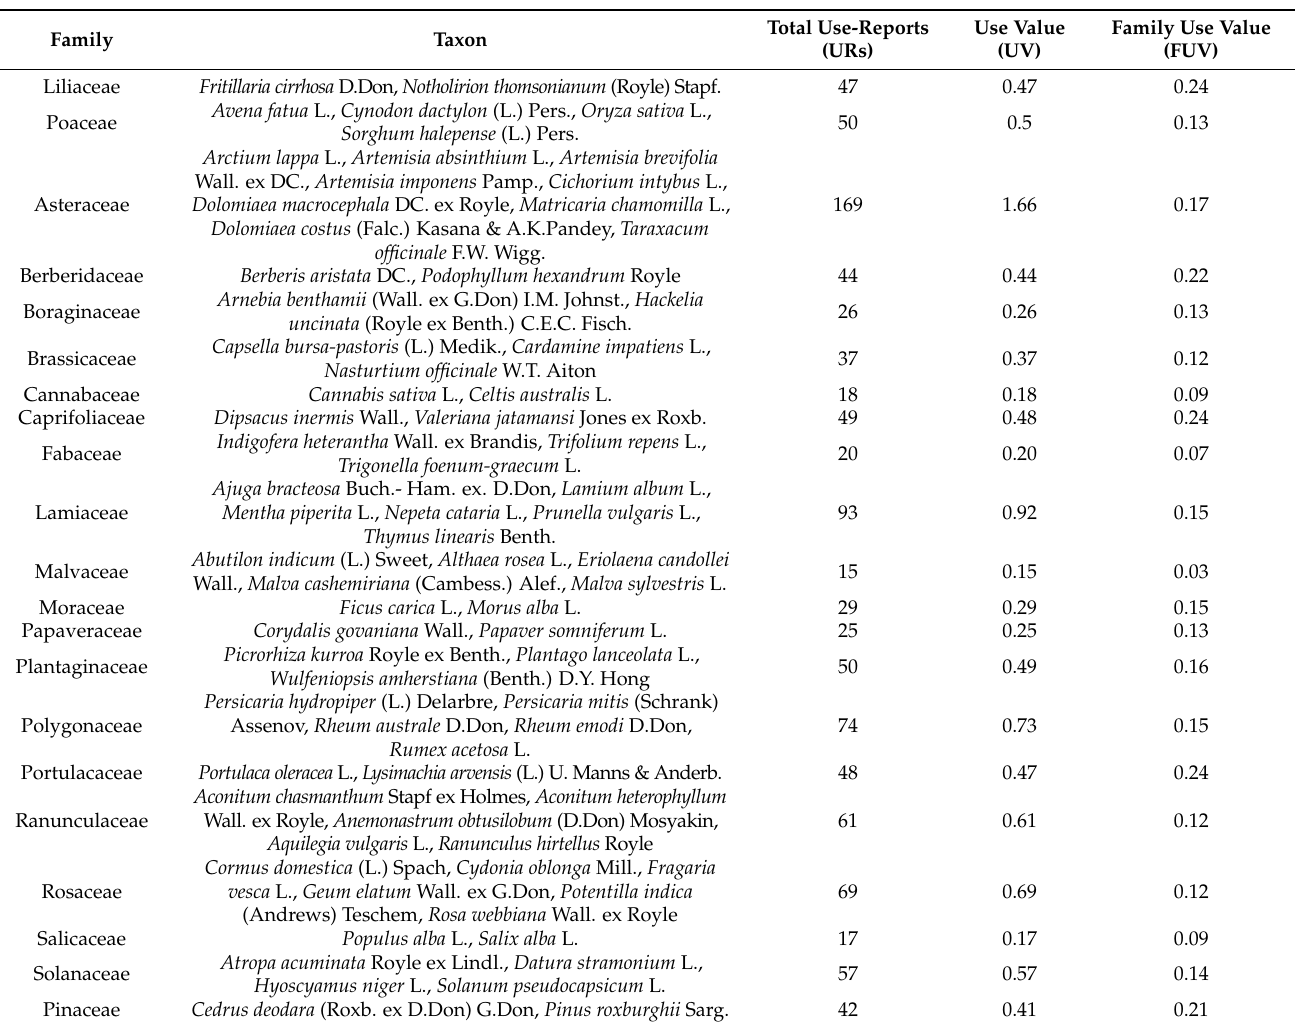
Table 4. Family use-value (FUV) of the study